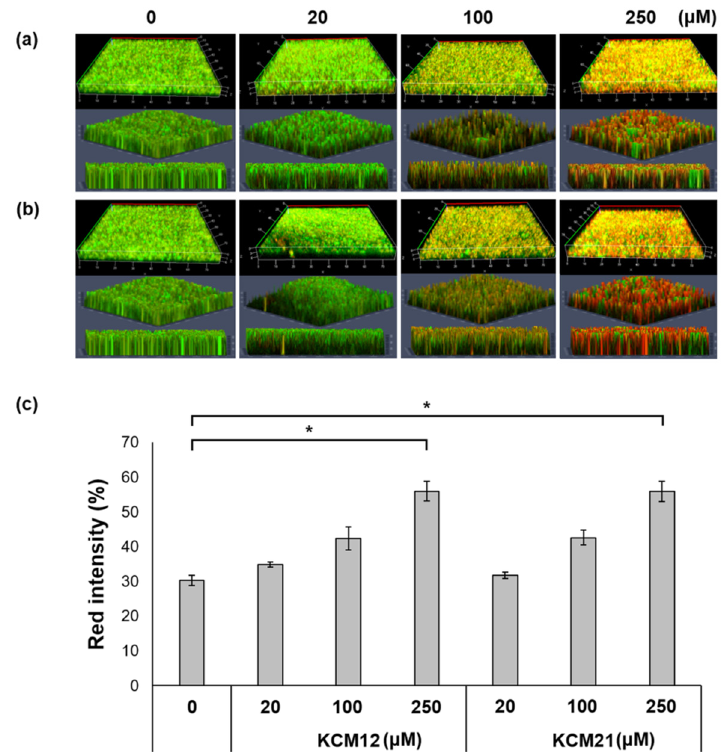
Figure 5. CLSM imaging analysis showing biofilm formation of Pst DC3000 after ( a ) KCM12 and ( b )